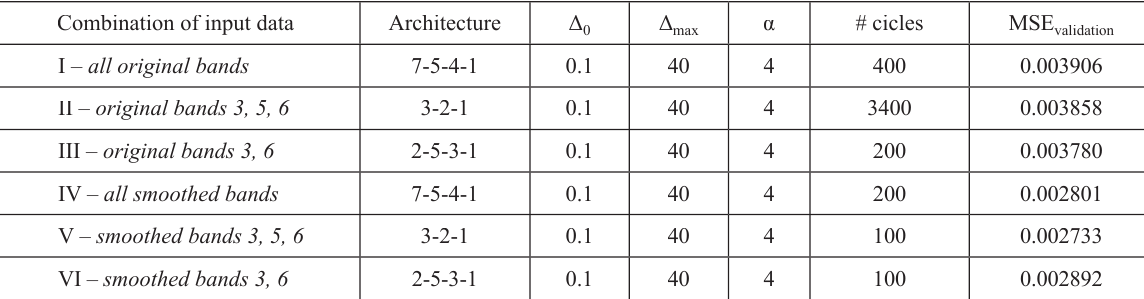
Descriptive statistics of the training and validation